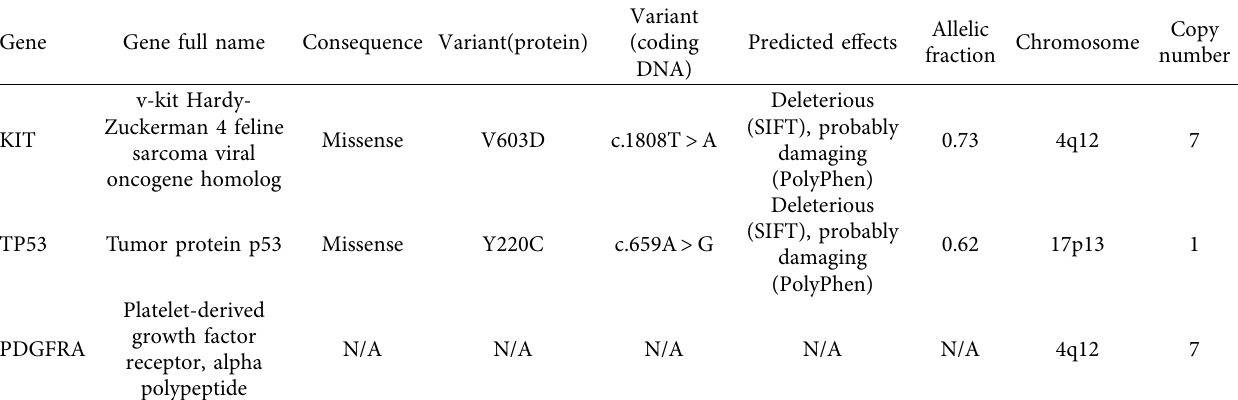
Figure 2: Histopathology. (a) Hematoxylin and eosin stain demonstrates a densely cellular spindle cell malignancy in partly fascicular or storiform pattern and areas of necrosis (100x magnification). (b) A higher magnification (200x) hematoxylin and eosin stain shows pleomorphic cells with a high mitotic rate, exceeding 20 mitoses per 10 high power fields. (c) The Ki-67 index is estimated at > 75% (100x magnification). (d) Immunohistochemical staining for p53 nuclear expression is seen in > 90% of cells (100x magnification). Table 1: Results from the targeted cancer gene panel of the index